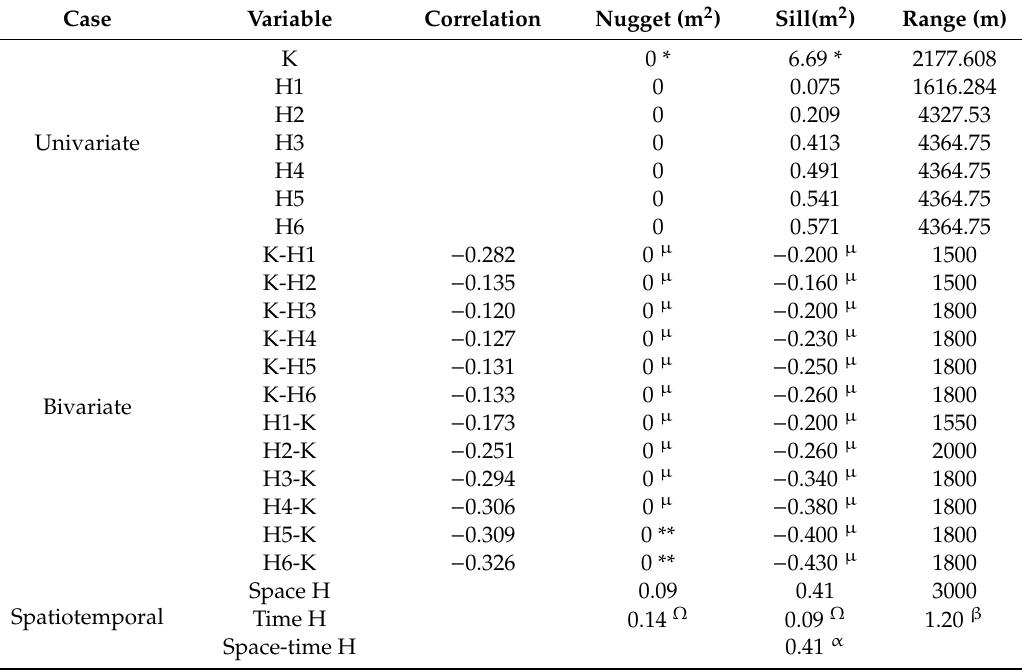
Table 5. Parameters of the fitted variogram models.